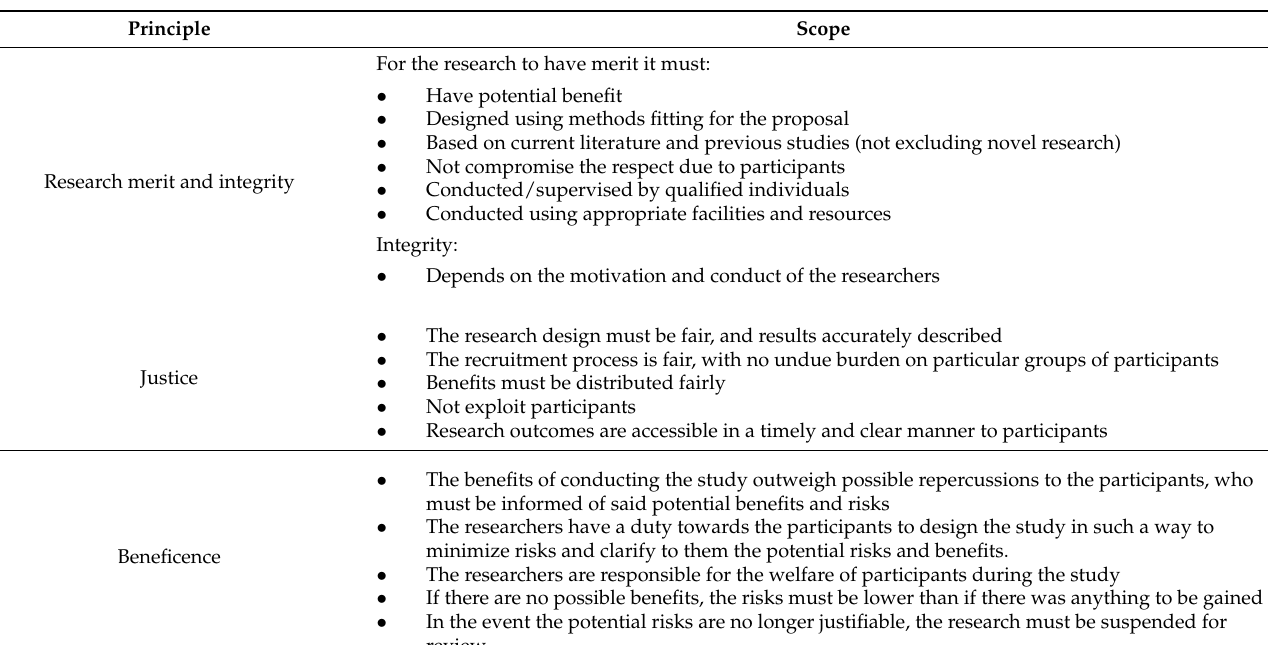
Table A1. Summary of the principles and themes of the Australian National Statement on Ethical Conduct in Human Research 2007 (Updated 2018)